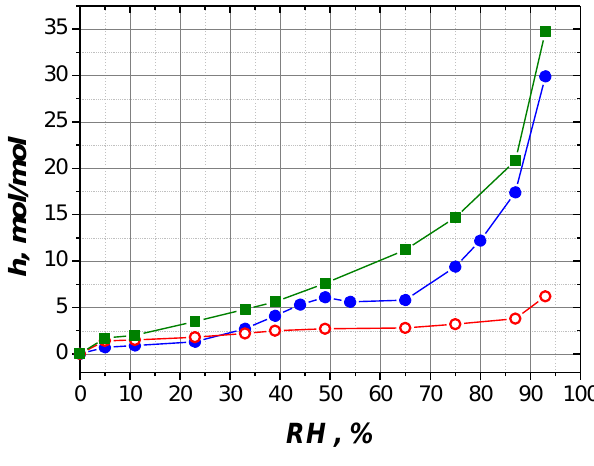
Figure 6. Water sorption on polycrystalline samples of NaAMP (empty circles), Na ATP (filled circles) and Na 2 reference